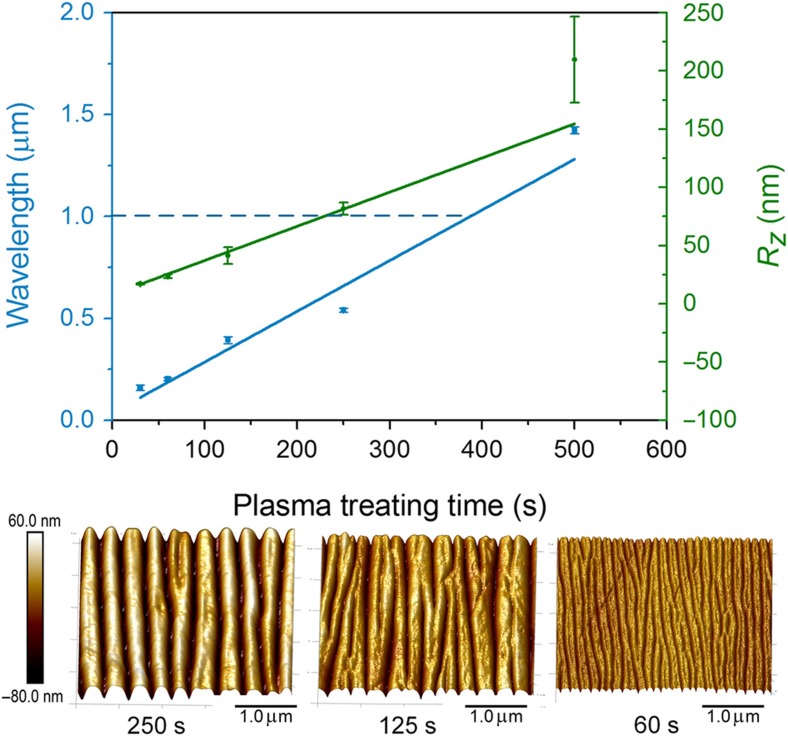
The effect of plasma-treating time on the wrinkle topology for the PDMS membranes: the wavelength, λ, and the surface roughness, Rz, as a function of the plasma-treating time; the selected AFM images of wrinkle structure with a plasma-treating time of 250, 125, and 60 s.